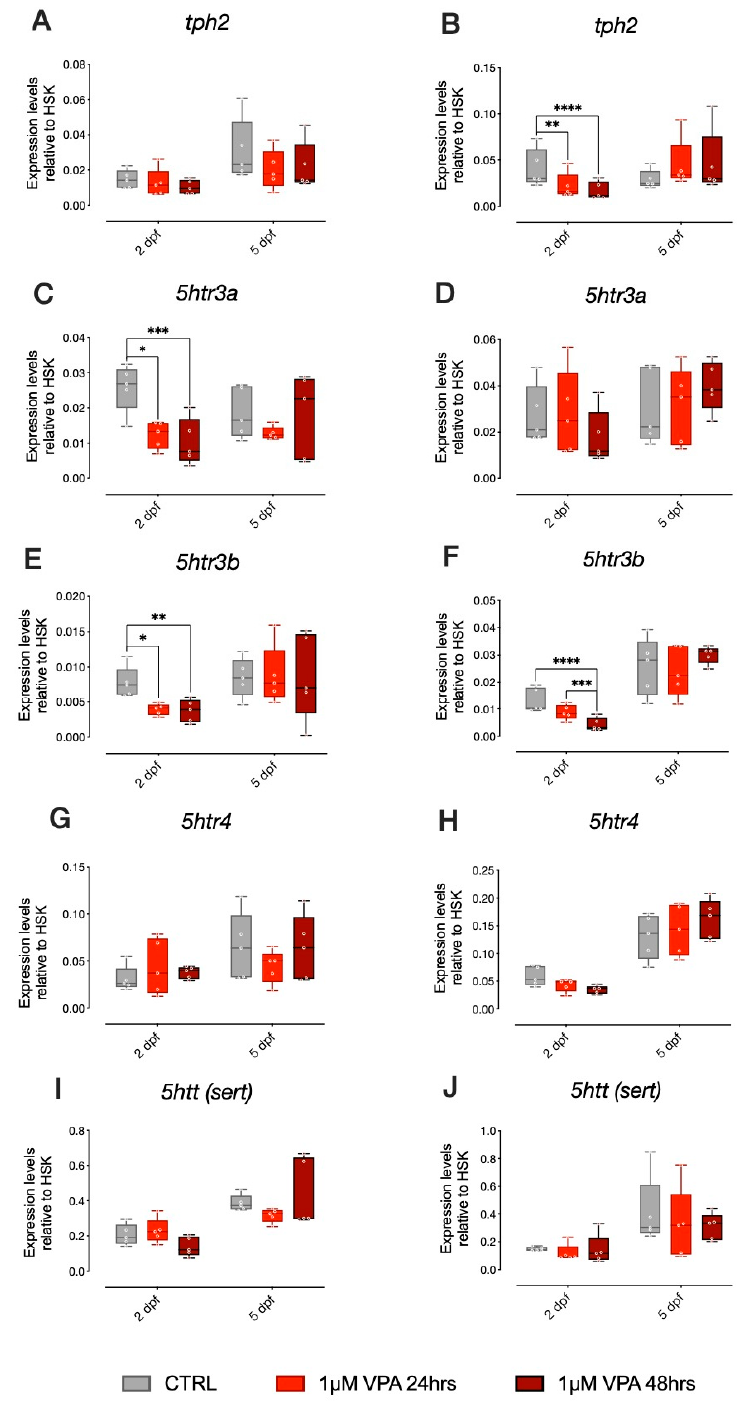
Figure 3. mRNA expression of key genes of serotoninergic system in 2 dpf and 5 dpf AB and TU zebrafish after 24 or 48 h of 1 µM VPA. Changes in the expression of tph2 ( A , B ), 5htr3a ( C , D ), 5htr3b ( E , F ), 5htr4 ( G , H ) and 5htt (sert) ( I , J ) in AB ( A , C , E , G , I ) and TU ( B , D , F , H , J ) zebrafish embryos. Box plot (median, min to max) of mean dCt values for each group. **** p < 0.0001, *** p < 0.001, ** p < 0.01, * p < 0.05.